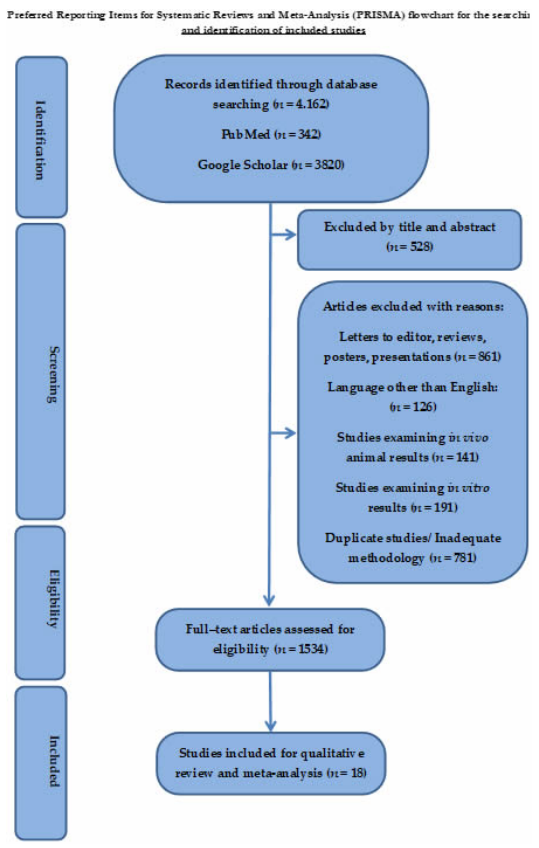
Figure 1. Preferred Reporting Items for Systematic Reviews and Meta-Analysis (PRISMA) flowchart for seeking and identifying included studies.